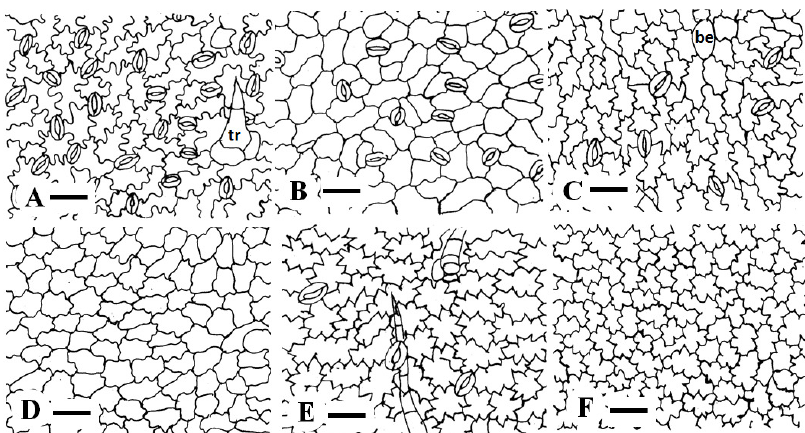
Fig. 3. Epidermal characteristic of B. hispida : Leaf (A and B); female flower (C and D) and male Flower (E and F) bar = 45µm